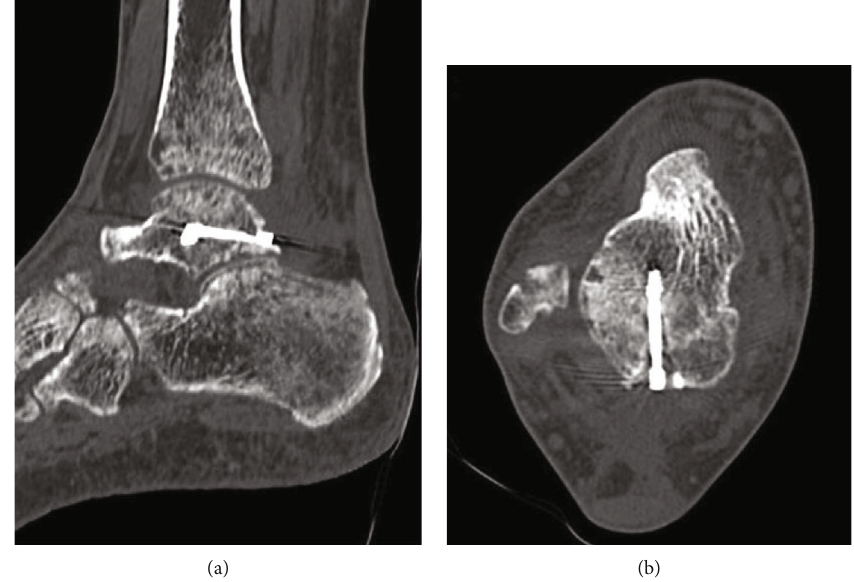
Figure 5: Noncontrast CT in (a) sagittal and (b) axial views at 14 weeks after the operation demonstrated complete bone